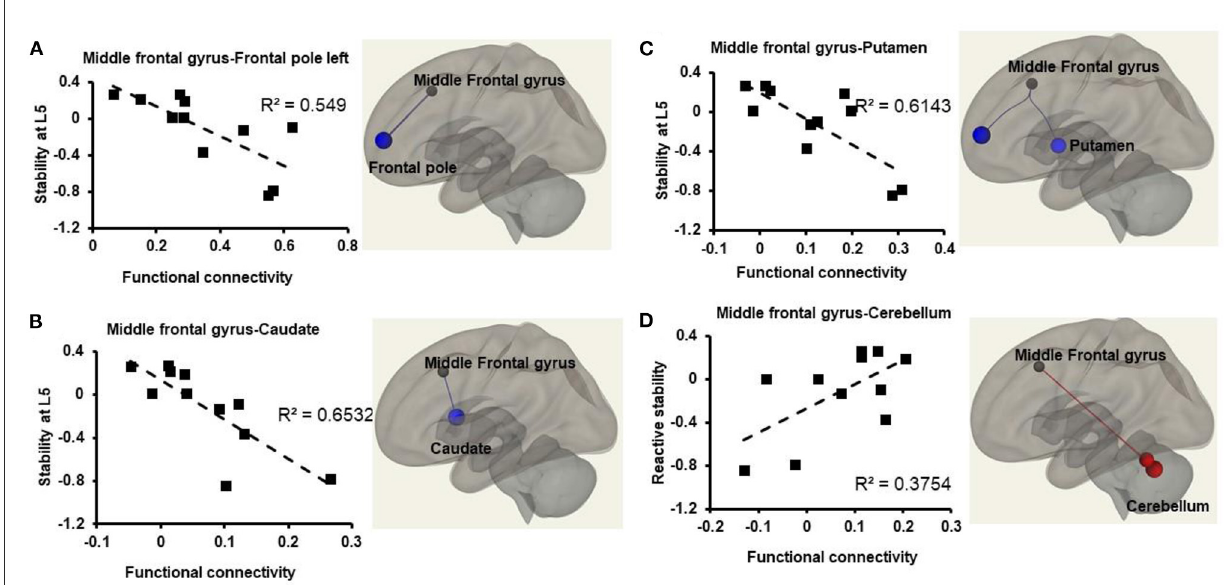
FIGURE2 Relationship between atlas-atlas network (represented in z-scores on the x-axis) and reactive stability (represented on the y-axis) in older adults with mild cognitive impairment. Weakened connectivity in the brain is indicated via blue lines and increased functional connectivity with red lines. (A) Weakened functional connectivity between middle frontal gyrus and frontal pole left in the brain such that older adults with mild cognitive impairment with higher reactive stability exhibited lower functional connectivity strength during resting state. (B) Weakened functional connectivity between middle frontal gyrus and caudate in the brain such that older adults with mild cognitive impairment with higher reactive stability exhibited lower functional connectivity strength during resting state. (C) Weakened functional connectivity between middle frontal gyrus and putamen in the brain such that older adults with mild cognitive impairment with higher reactive stability exhibited lower functional connectivity strength during resting state. (D) Increased functional connectivity between middle frontal gyrus and cerebellum such that older adults with mild cognitive impairment with higher reactive stability exhibited higher functional connectivity strength during resting